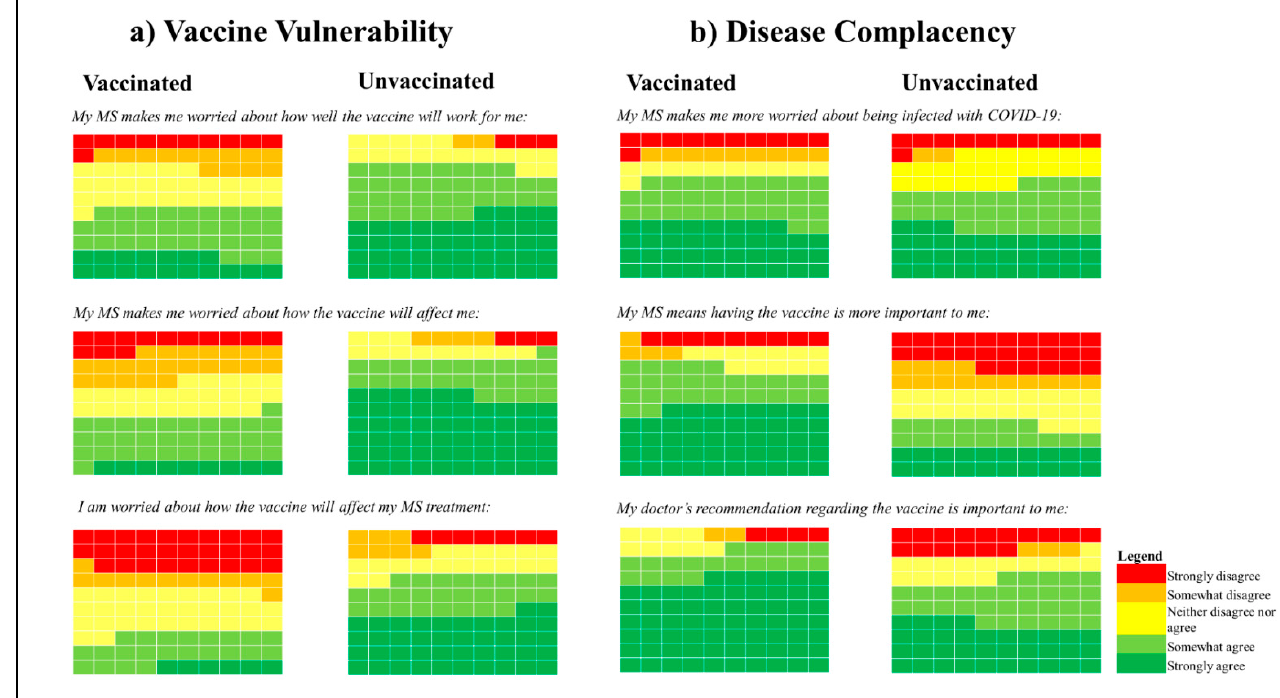
Figure 2. The frequencies of the five possible responses for each item of the DIVAS-6 subscales: ( a ) vaccine vulnerability ( b ) disease complacency. Each single-coloured box represents 1% of patient participant responses for each item, by vaccination status. ‘Don’t know’ responses were excluded. Abbreviations: DIVAS-6, Disease Influenced Vaccine Acceptance Scale-6.